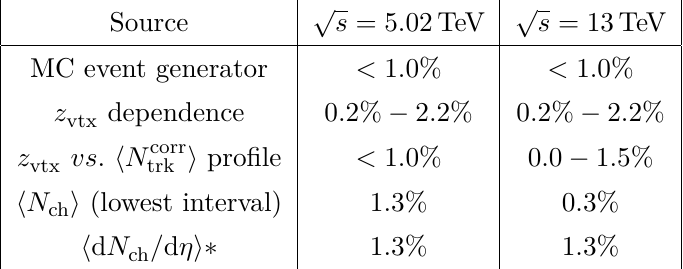
Table 3 . The summary of systematic uncertainties for charged-particle density measurements. The value marked with (*) is taken from the ref. [49].